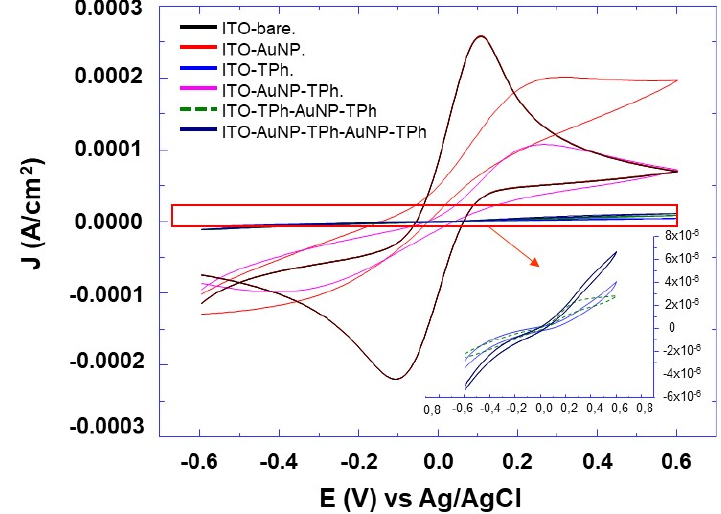
Figure 9. Cyclic voltammetric (CV) curves of ITO electrodes modified with different architectures of AuNPs and 4-thiolphenyl as indicated in the inserted sketch, The measurements were recorded with a scan rate of 10 mV s − 1 , in aqueous solution of of [Fe(CN) 6 ] 3 − / 4 − (1:1, 10 − 2 M) and 0.1 M KCl.